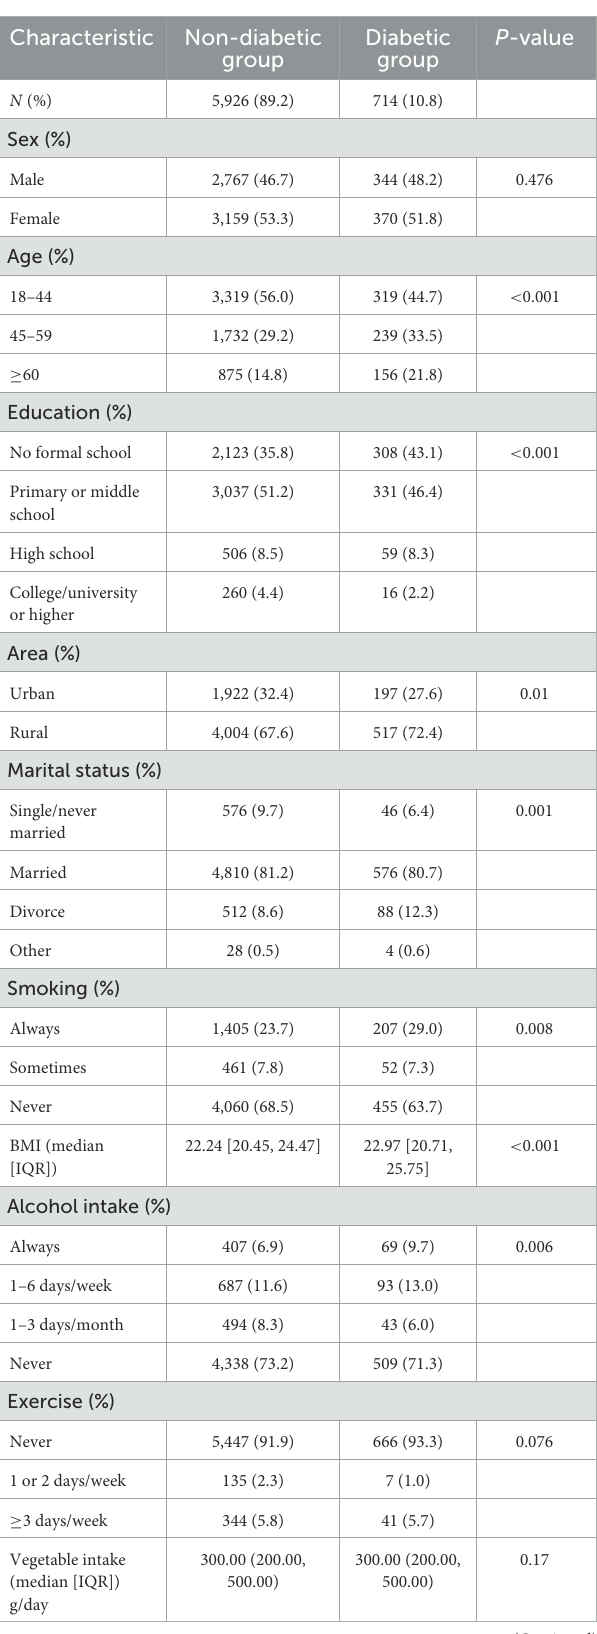
TABLE 1 Sociodemographic characteristics and consumption rates of pickled vegetables and fermented bean curd among study participants.